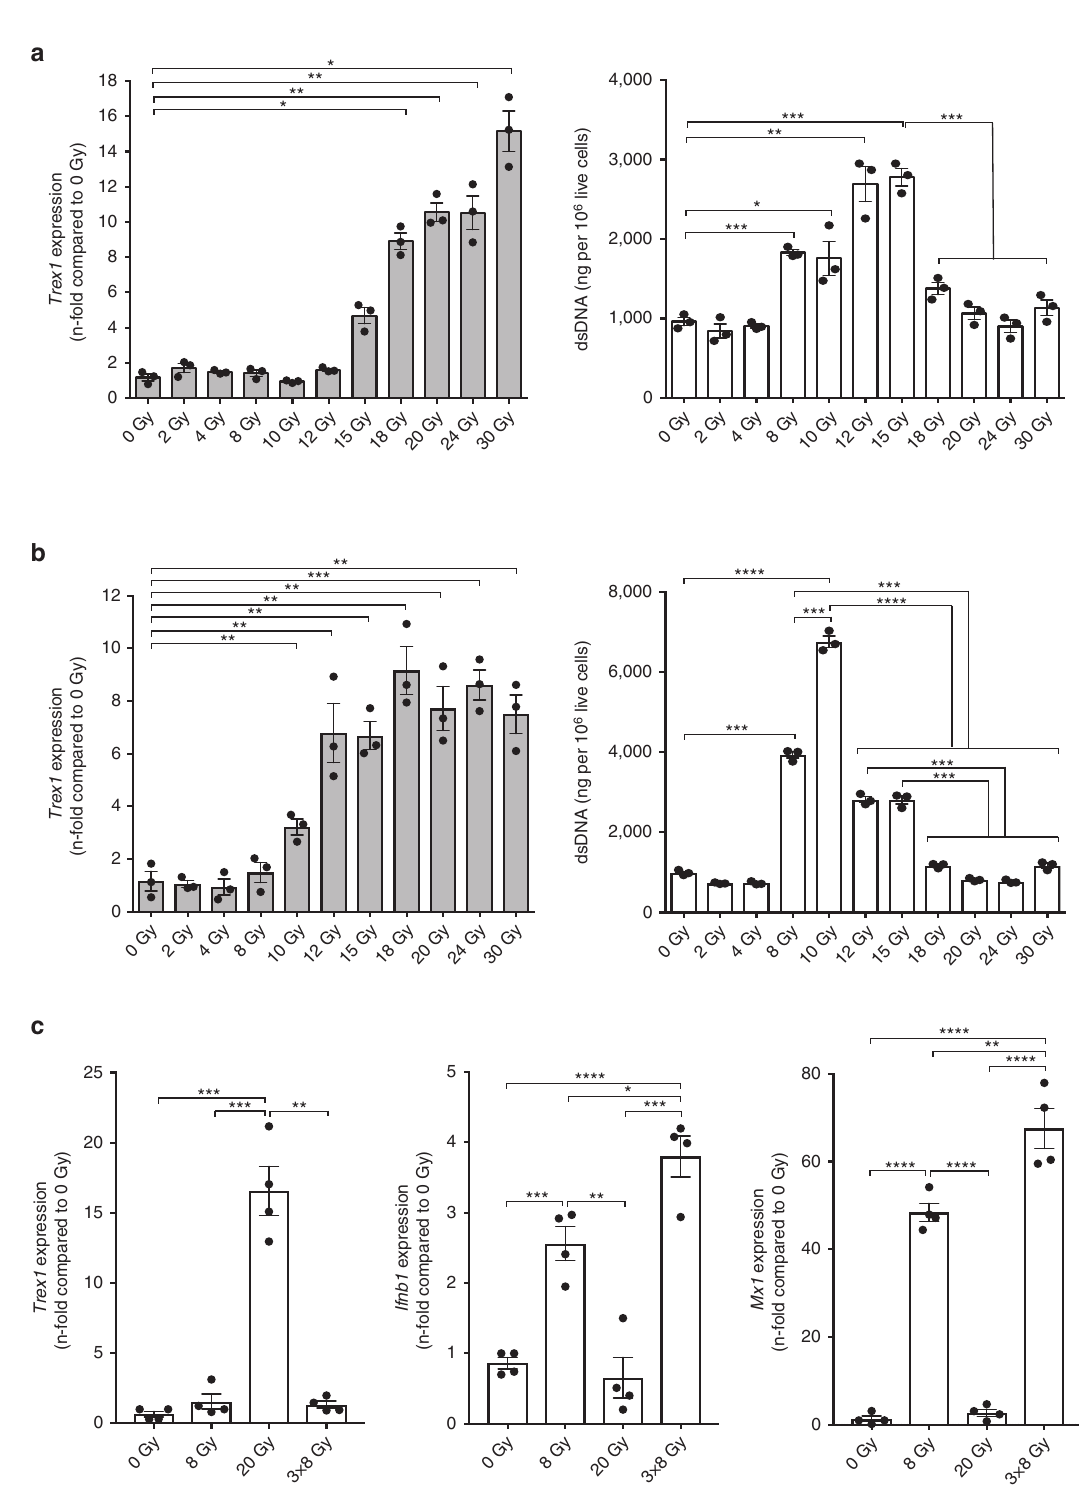
Figure 8 | Threshold for Trex1 induction by radiation in human cell lines and induction of Trex1 and IFN-I pathway in a patient-derived lung adenocarcinoma xenograft. ( a , b ) Trex1 expression and cytoplasmic dsDNA accumulations in MDA-MB-231 ( a ) and 4175TR ( b ) breast carcinoma cells 24 hrs after in vitro treatment. Duplicate; * P o 0.05; ** P o 0.005; *** P o 0.0005: t -test; n ¼ 3. All data are mean ± s.e.m. ( c ) Trex1 , Ifnb1 and Mx1 expression measured by qRT-PCR in a patient-derived tumour xenograft (PDTX) 24h after mice treatment with tumour-directed radiation. Duplicate; * P o 0.05; ** P o 0.005; *** P o 0.0005: t -test; n ¼ 4. All data are mean ± s.e.m. under pathogen-free conditions in the animal facility at New York University University of New Jersey. BALB/c Batf3 (cid:2) / (cid:2) mice were purchased from Jackson School of medicine and Weill Cornell Medicine and used between 6 and 10 weeks and bred in house. NOD/SCID/gamma (NOG) female mice (CIEA NOG mouse; of age. All experiments were approved by the Institutional Animal Care and Use NOD.Cg- Prkdc scid Il2rg tm1Sug /JicTac) were purchased from Taconic Animal Laboratory (Germantown, NY, USA). All female and male mice were maintained Committee at both institutions. NATURE COMMUNICATIONS|8:15618|DOI: